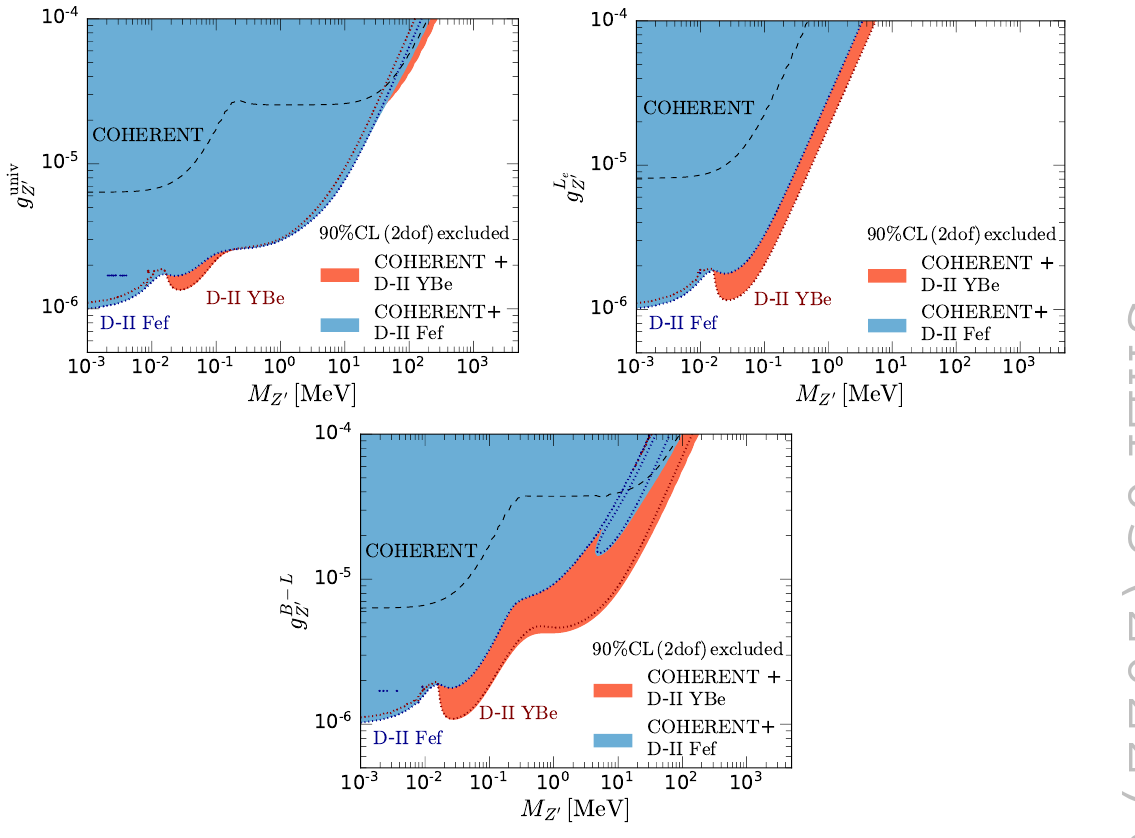
Figure 6 . Upper left panel: 90% CL (2 dof, two-sided, ∆ χ 2 = 4 . 61 ) excluded regions for models with light vector mediators coupled universally to all relevant fermions. Upper right panel: 90% CL (2 dof, two-sided, ∆ χ 2 = 4 . 61 ) excluded regions for models with light vector mediators coupled only to L e . Lower panel: 90% CL (2 dof, two-sided, ∆ χ 2 = 4 . 61 ) excluded regions for models with light vector mediators coupled only to B − L . The thick blue and red dotted lines show the boundary of the region excluded by the Dresden-II reactor experiment with the Fef and YBe quenching factors, respectively. The black dashed line shows the boundary of region excluded from the analysis of COHERENT CsI and Ar data. The filled regions are those excluded by the combined COHERENT+Dresden-II